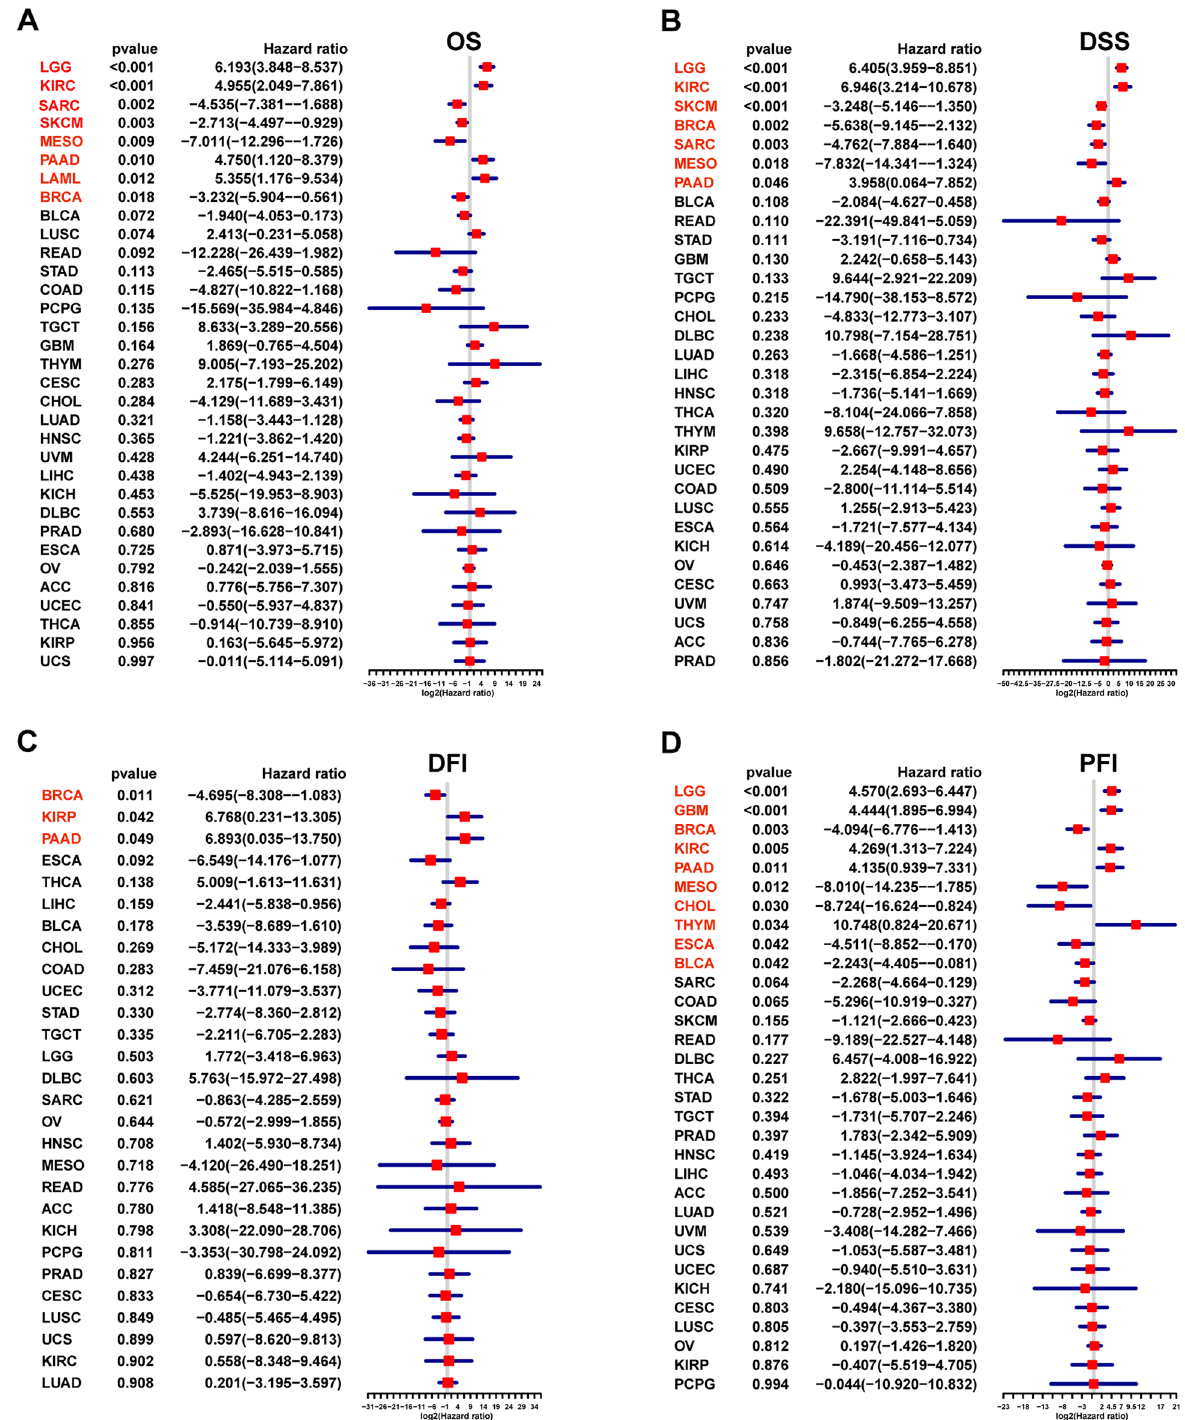
Figure 7. The association between PANoptosis score and survival prognosis in pan-cancer. ( A ) Overall survival. ( B ) Disease-specific survival. ( C ) Disease-free interval. ( D ) Progression-free based on the HALLMARK terms. The PANoptosis score was positively correlated with many malignant pathways in pan-cancer, especially IL6-JAK-STAT3 signaling, interferon-gamma response, inflammatory response, IL2- STAT5 signaling, and TNF-a signaling via NF-kB signaling (Fig. 8). These results suggest that the PANoptosis score markedly affects the inflammatory response and the tumor immune microenvironment. PANoptosis scores are associated with TME and immune cell infiltration. Increasing evidence suggested that the TME plays a critical role in multidrug resistance, tumor progression, and metastasis 23 . To